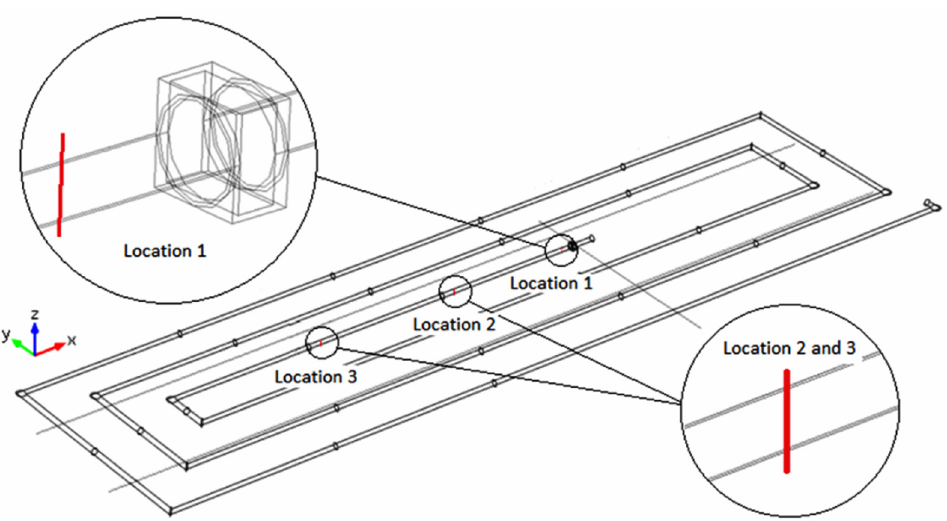
Figure 14. Identification of the three locations for analysis.